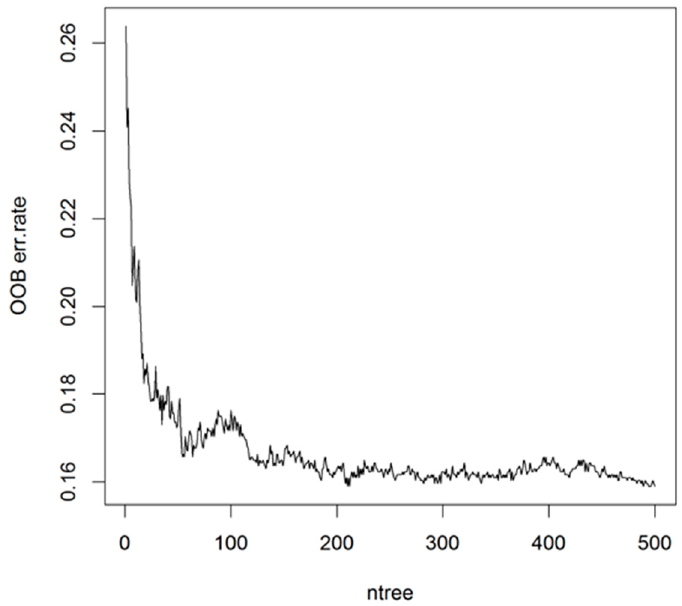
Figure 14. Out-of-bag error plot of the random forest (RF) algorithm for the study area.